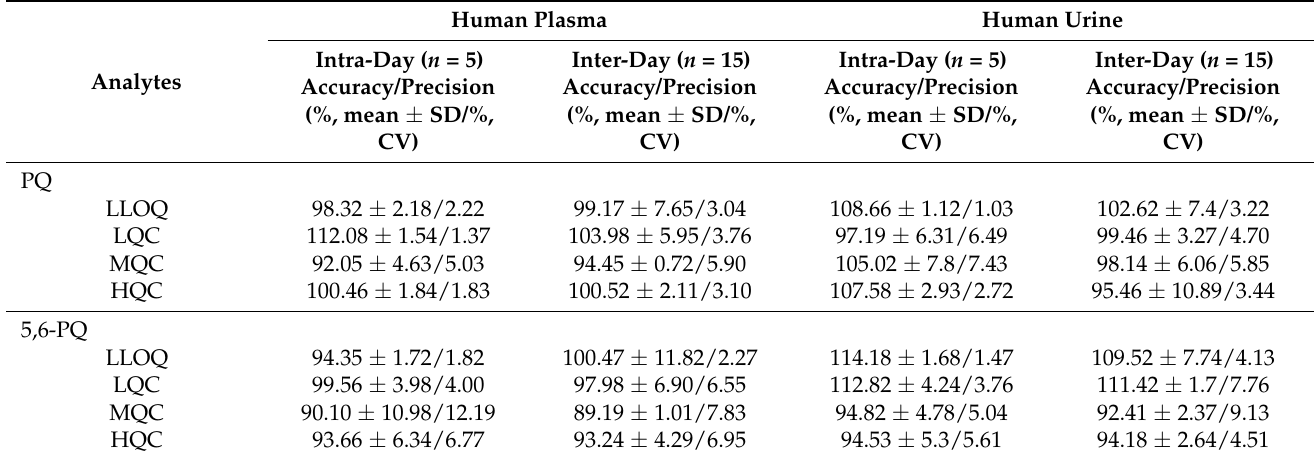
Table 2. Accuracy and precision analysis of PQ and 5,6-PQ in human plasma and urine.